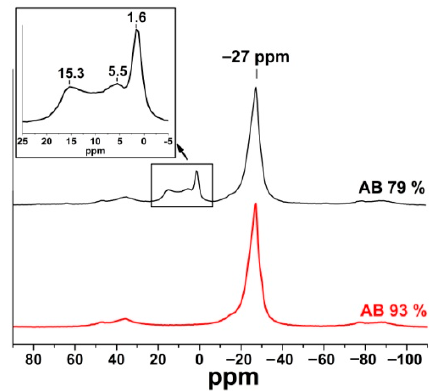
Figure 2. 11 B MAS NMR data for samples of NH 3 BH 3 with different purities.